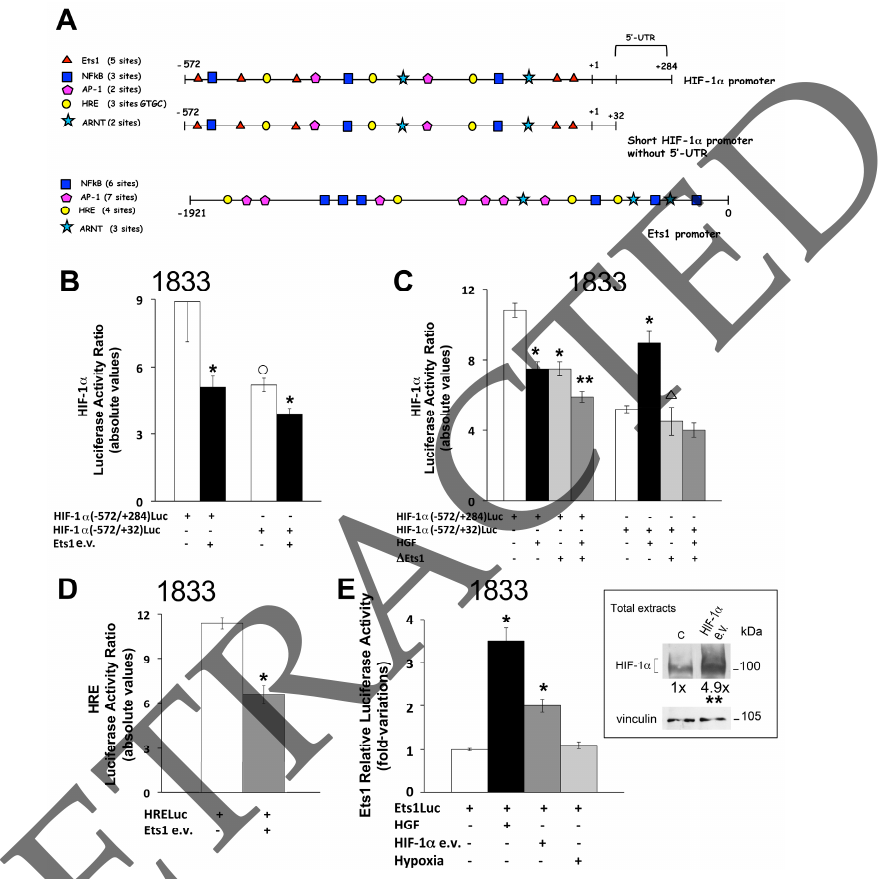
Figure 4. In 1833 cells the transactivation of HIF-1 α was affected by Ets-1 e.v. and vice versa . ( A ) The